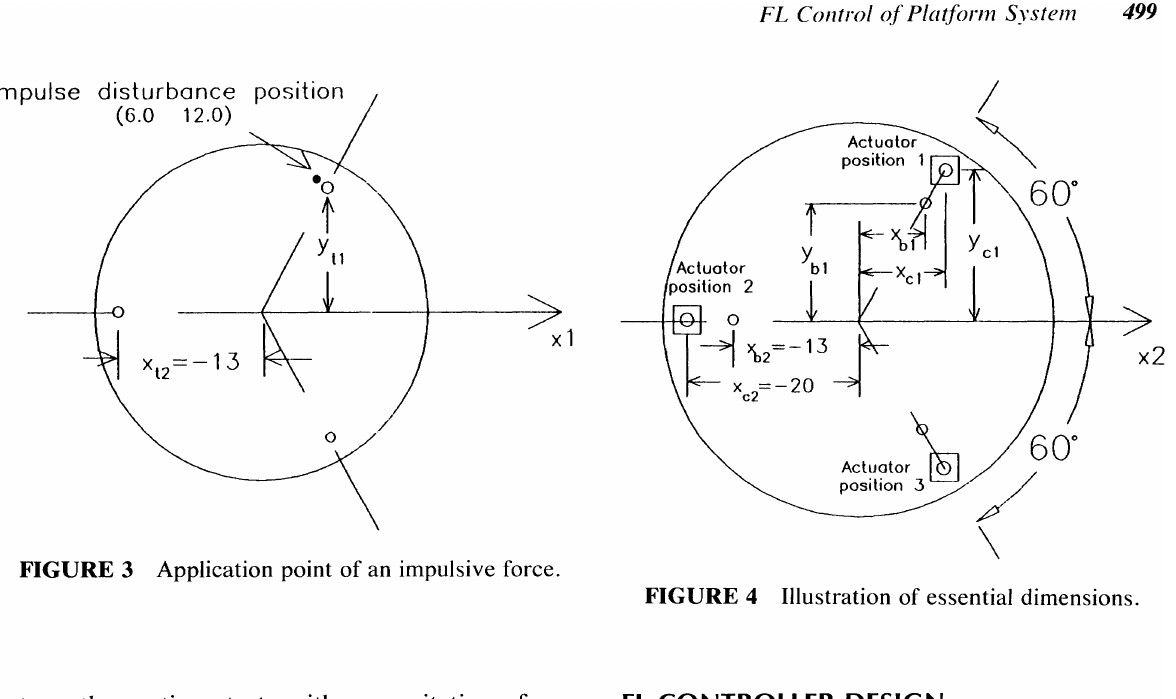
FIGURE 4 Illustration of essential dimensions.